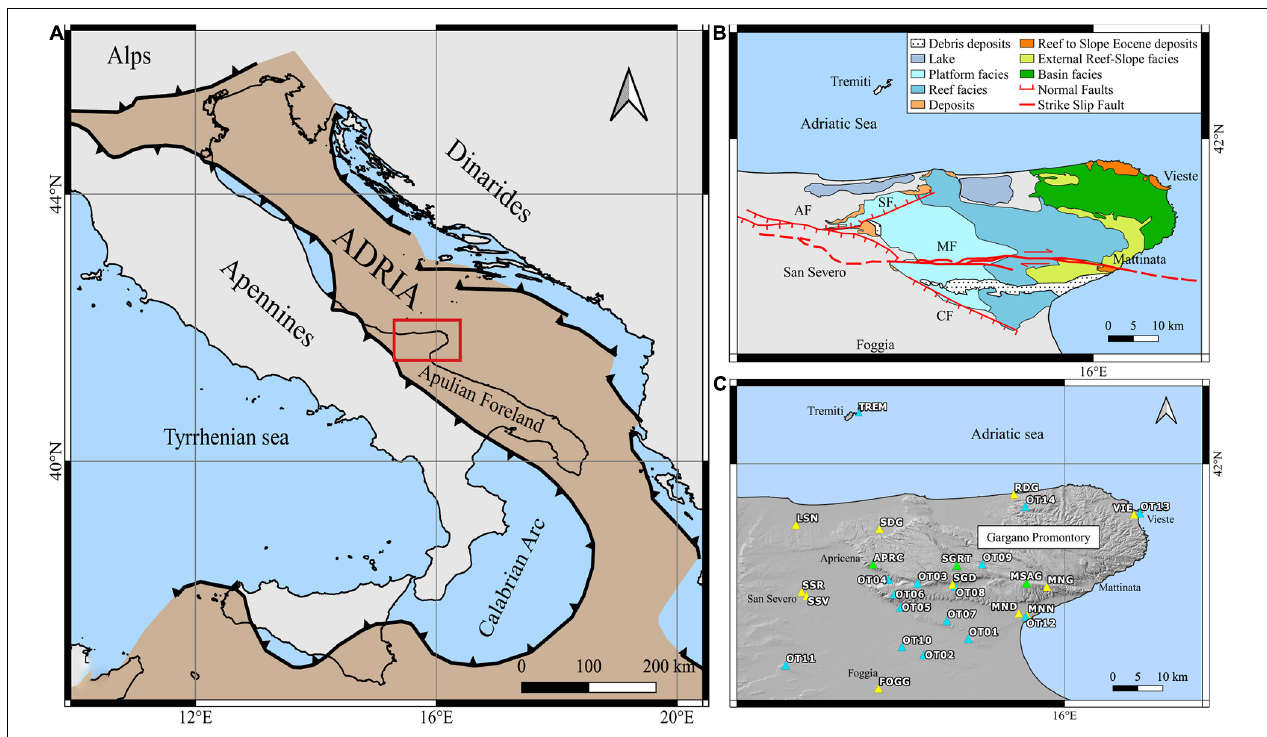
FIGURE 1 | (A) Adria microplate (brown area) as reported by Mantovani et al. (2006). The red square indicates the area investigated in this paper. (B) Simplified geological map. The main stratigraphical and geological features are reported (Salvi et al., 1999; Chilovi et al., 2000; Bosellini and Morsilli, 2001; Patacca and Scandone, 2004); colors of the stratigraphic units refer to the ages of geological formations: Jurassic facies, light blue; Cretaceous facies, green; Eocene facies, orange. We reported in the map the Mattinata Fault (MF), the Apricena Fault (AF), the Candelaro Fault (CF), and the Sannicandro Fault (SF) as red lines, both continuous (that is observable on the ground surface) and discontinuous (that is hypothesized under the ground surface) and their dipping direction. (C) Enlargement on the red area of GP. The triangles refer to different seismic networks according to colors: green refers to RSN; light blue refers to OSN; yellow refers to